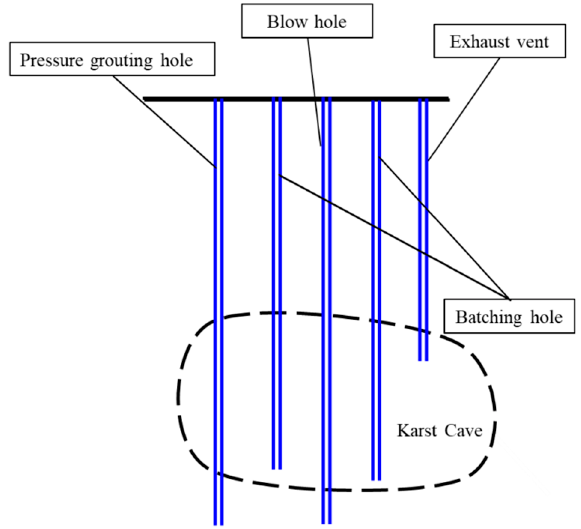
Figure 22. Drawing of grouting borehole.